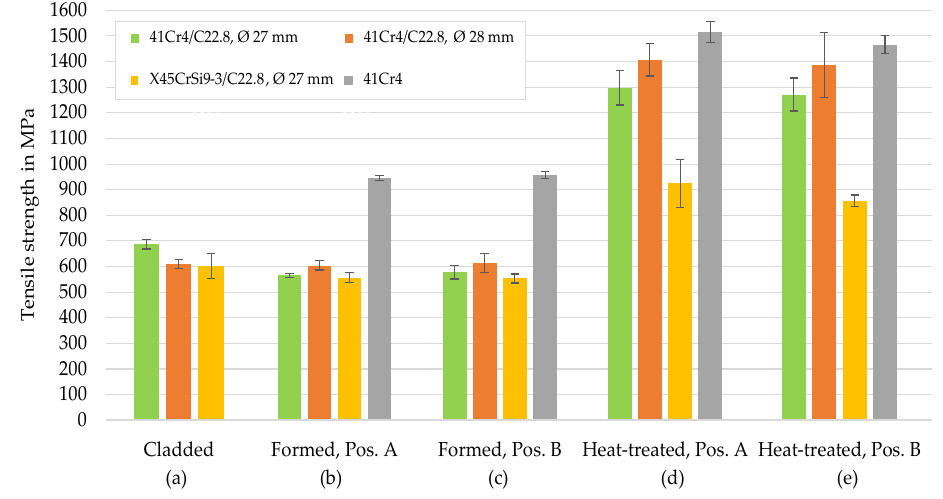
Figure 9. Tensile strength values of cladded workpieces ( a ), forged bevel gears at position A ( b ) and B ( c ), heat-treated bevel gears at position A ( d ) and B ( e ).